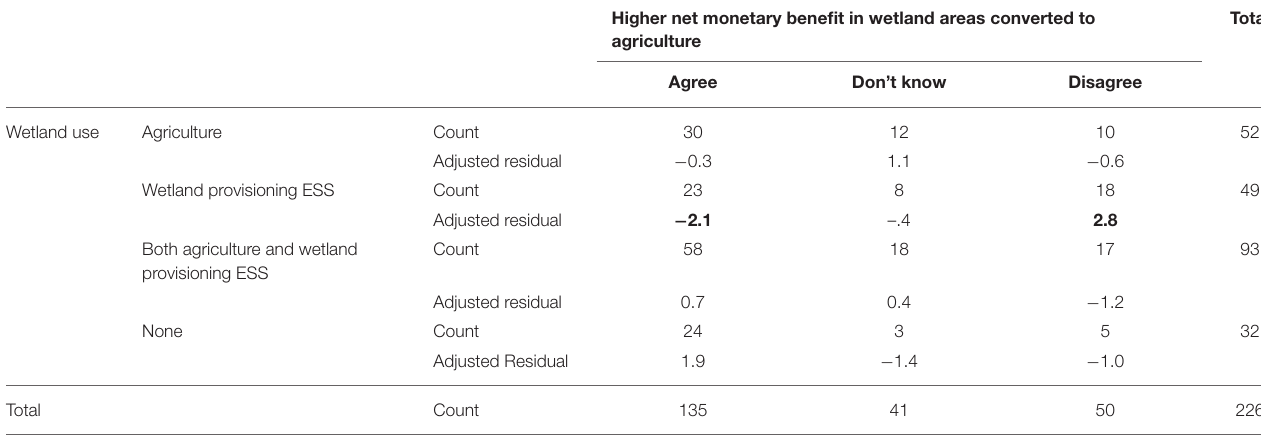
TABLE 7 | Association between the perception that agriculture has higher net monetary benefit than wetland provisioning ESS and use of the wetland. Higher net monetary benefit in wetland areas converted to